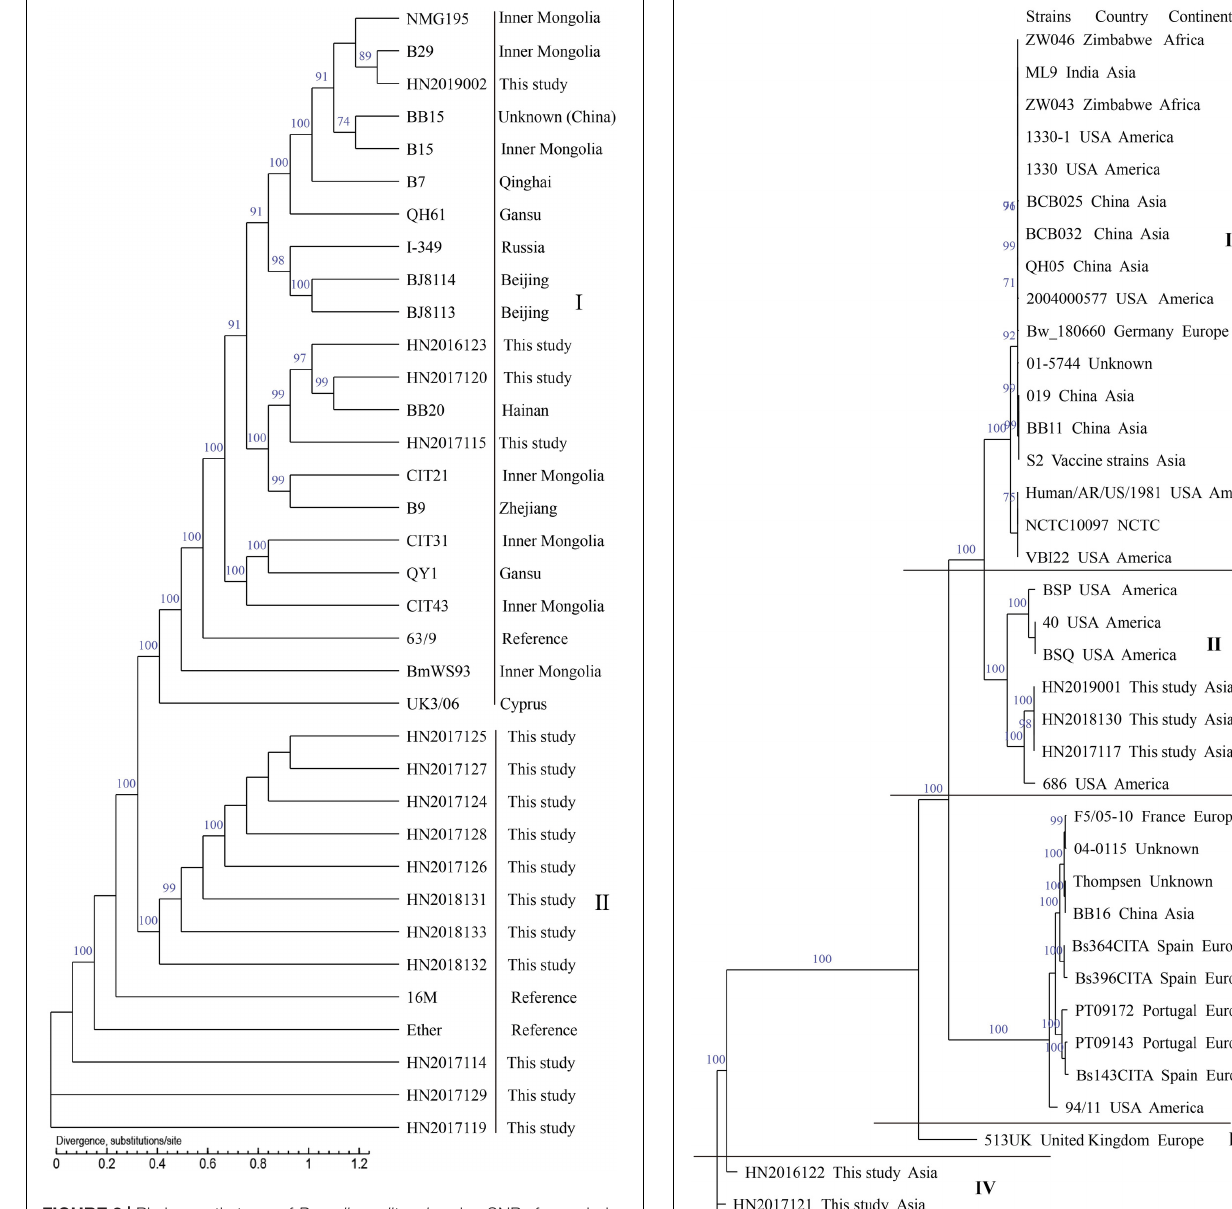
FIGURE 8 | Phylogenetic trees of Brucella melitensis using SNPs from whole genomes.